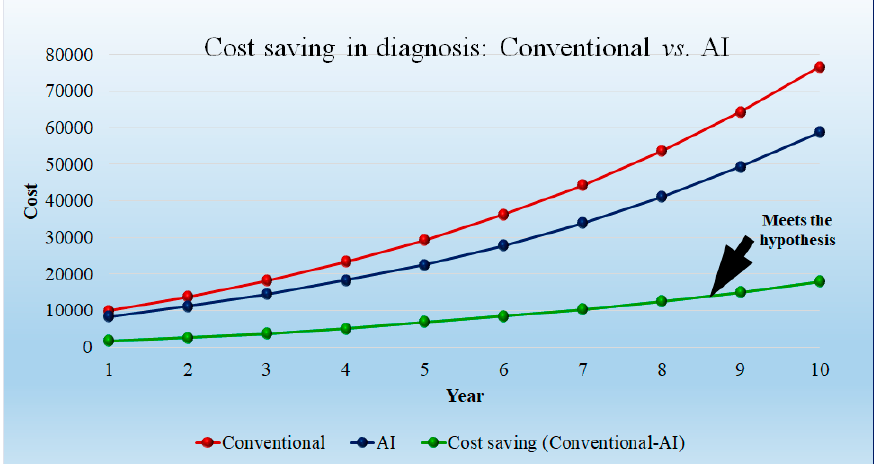
Figure 12. Cost saving (green) in diagnosis: conventional (red) vs. AI (blue).